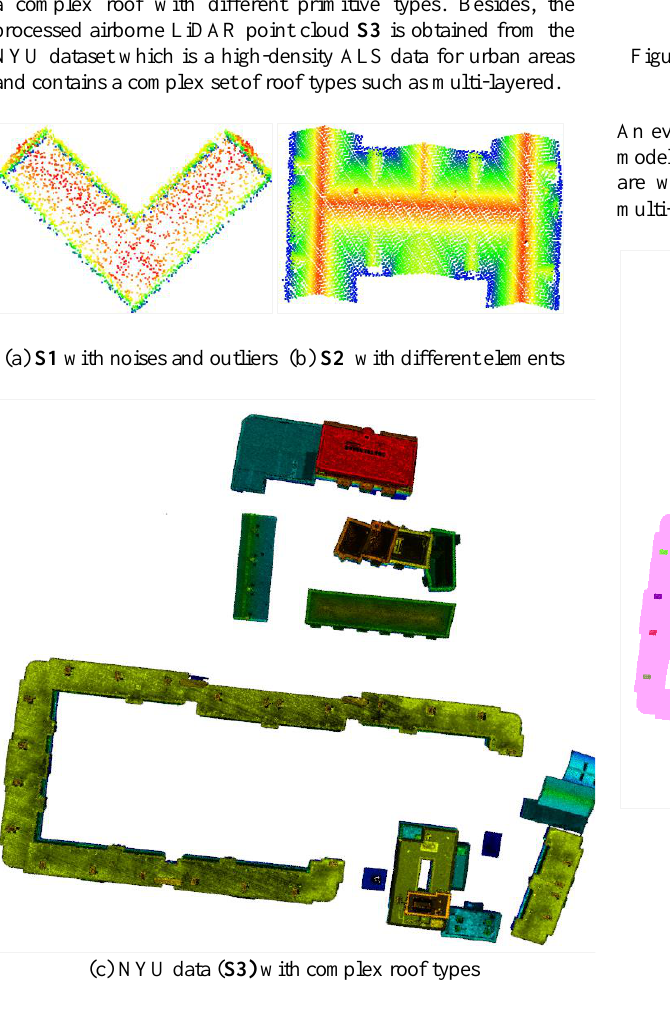
Figure 2. Overview of three tested point clouds